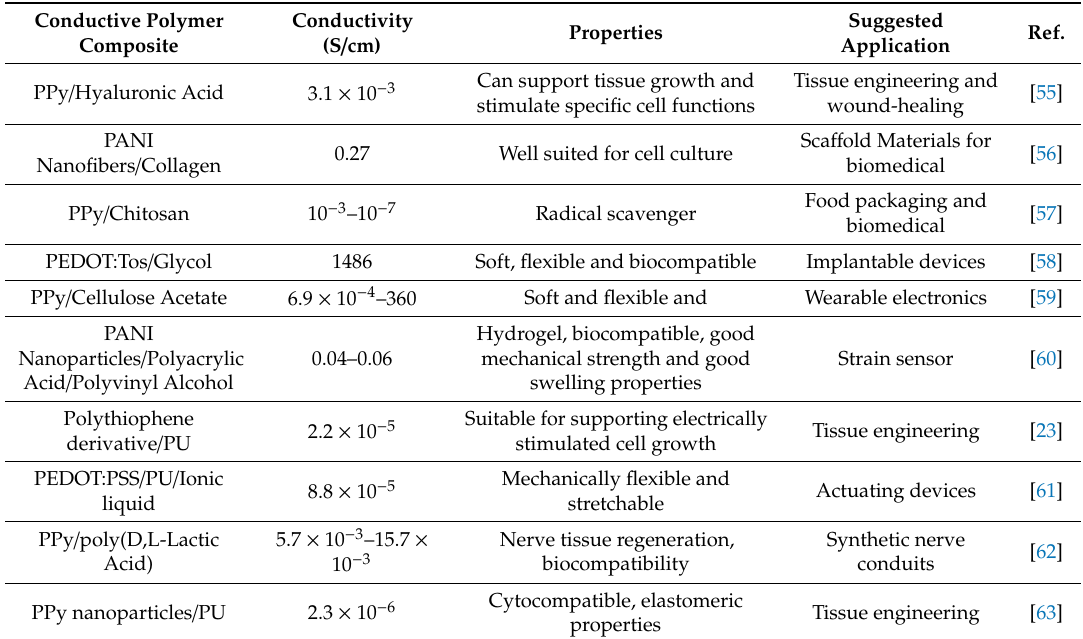
Table 2. Properties of common conductive polymer